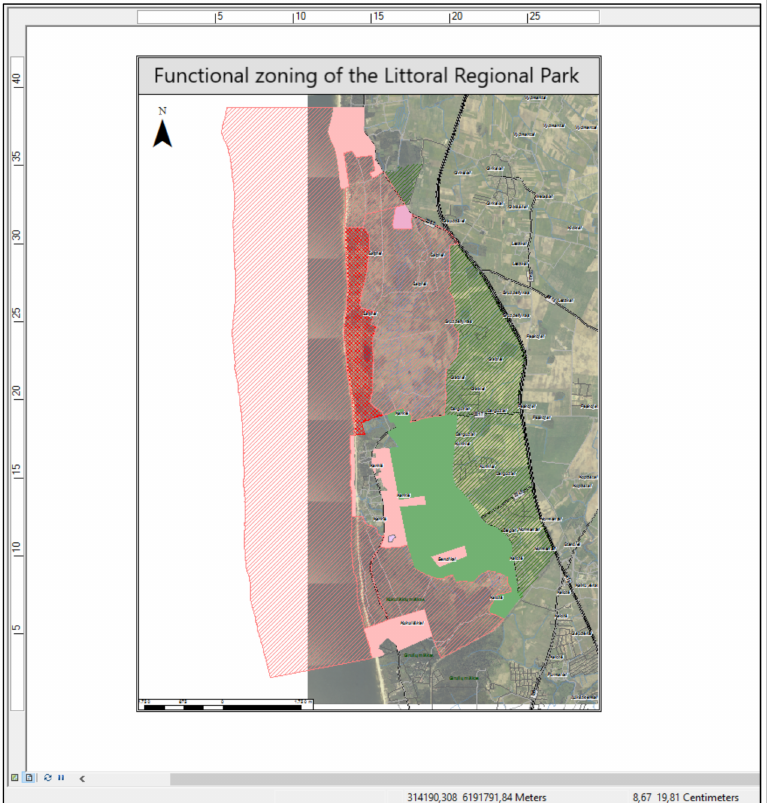
Figure 6. A GIS map of functional zoning of the Littoral Regional Park (plotted by Egidijus